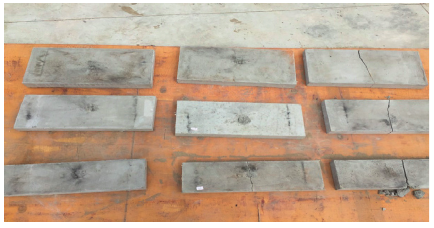
Figure 9: Overall damage of